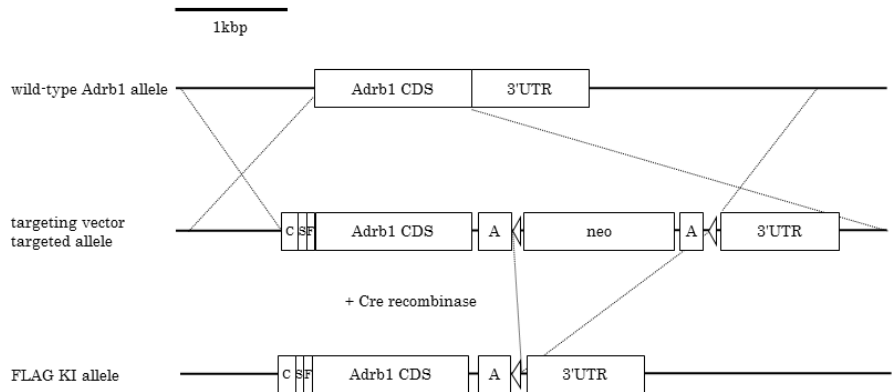
Figure 1. Targeted insertion of the gene for Adrb1 in mice. Structure of the wild-type Adrb1 allele ( top ), the targeting vector, and the targeted allele in mice ES cells ( middle ) and the resulting FLAG-tagged Adrb1 KI mice after Cre recombination ( bottom ). C, chimeric intron and kozak sequence; S, signal sequence; F, three times repeat FLAG tag; A, polyadenylation sequence; neo, neo cassette; outlined triangle, loxP.